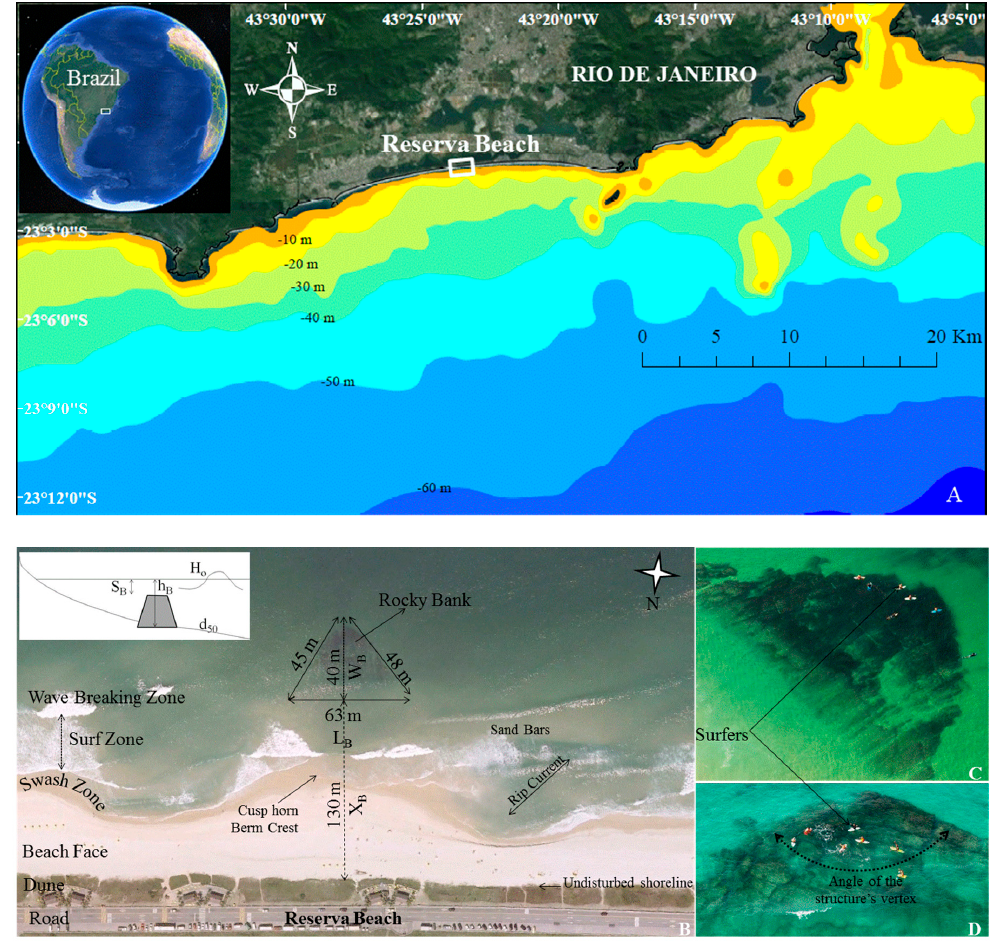
Figure 1. ( A ) Study area. ( B ) The environmental parameters (d 50 , sediment grain size; H o , incident wave height) and structural dimensions of the submerged structure in the beach system ( W B , crest width; h B , depth at structure; S B , depth to structure crest; L B , structure base length; X B , distance between shoreline reference and structure), used in non-dimensional models. ( C ) and ( D ) Reserva Beach rocky bank aerial